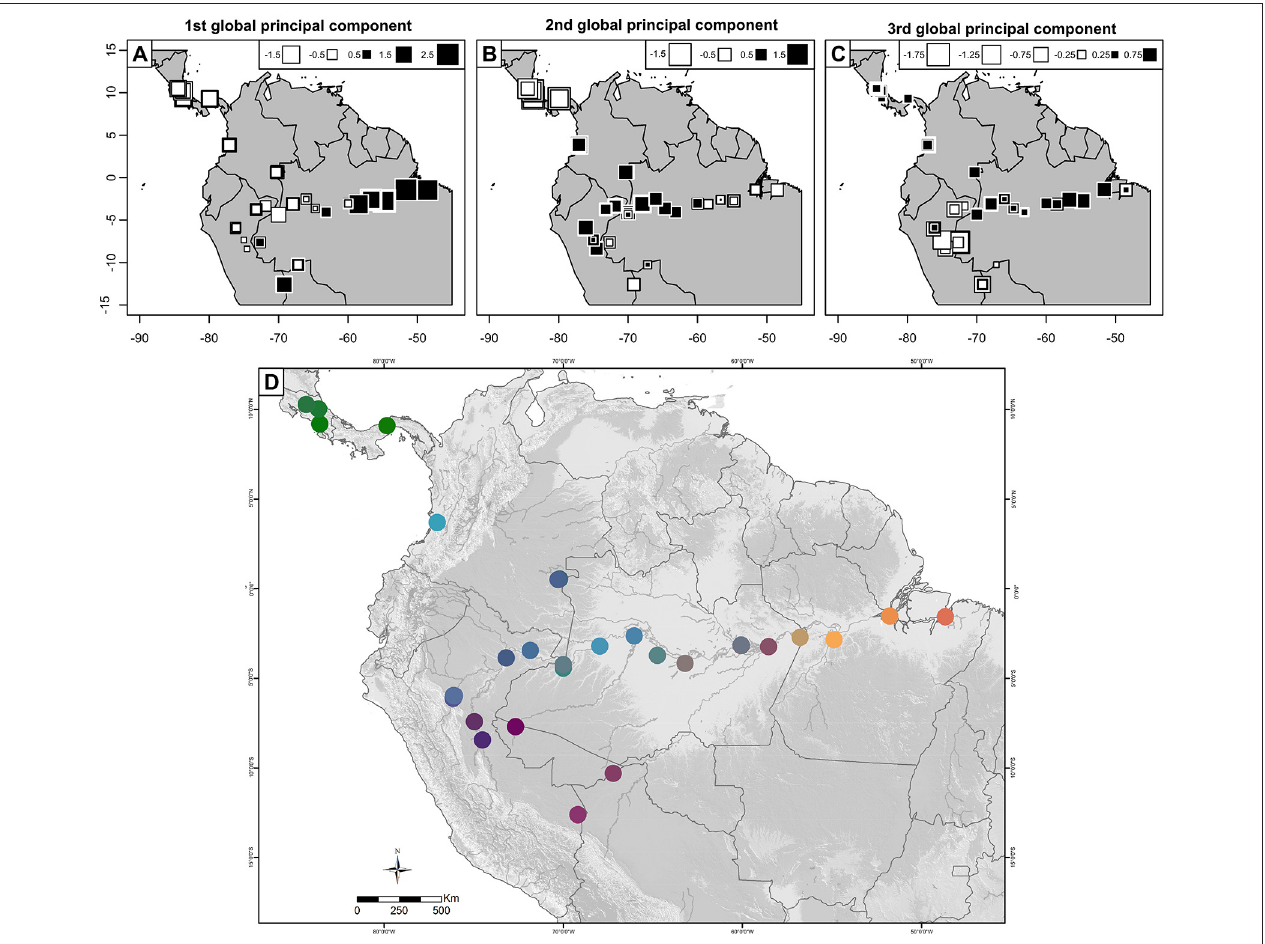
FIGURE 9 | Spatial principal component analysis of 156 peach palm ( Bactris gasipaes var. gasipaes ) accessions in the Core Collection estimated from 17 SSR markers. (A–C) Projections of accessions and their position on the first to the third global components. Size and color of squares is related to the samples positions on the considered component. (D) Synthetic projection of the three first components. The color is coded in RVB system by the position on the three components for each